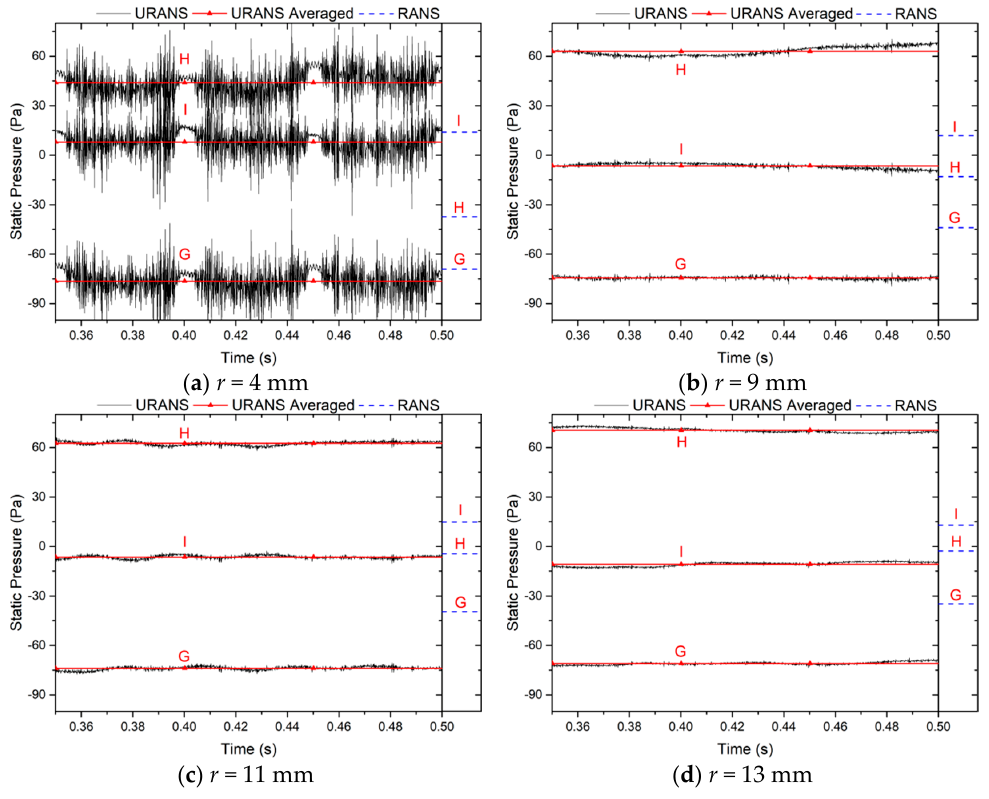
Figure 23. Static pressure fluctuation at monitors G/H/I.